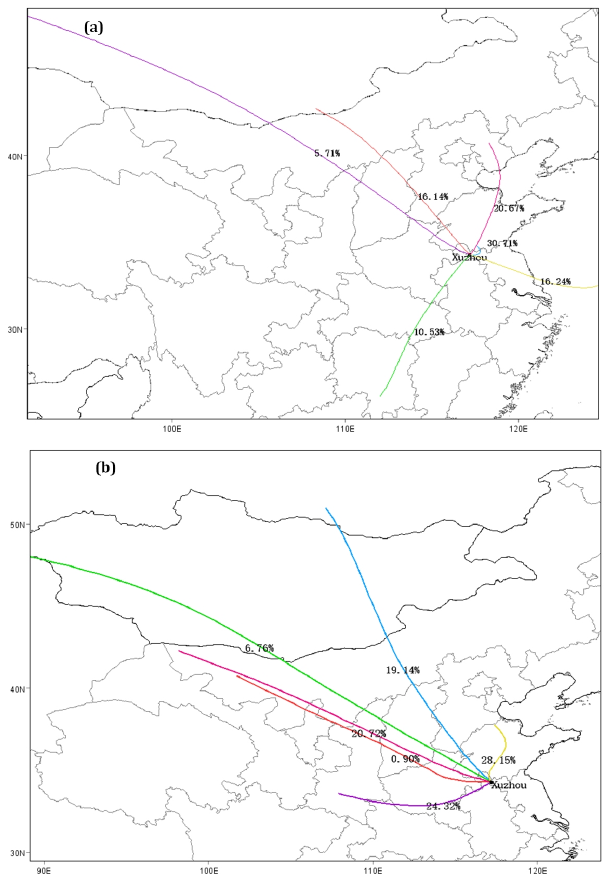
Figure 7. Cluster analysis of 48-h backward air mass trajectories arriving at Xuzhou at 1500 m above the ground every 6 h: ( a ) the heating season; ( b ) the nonheating season.